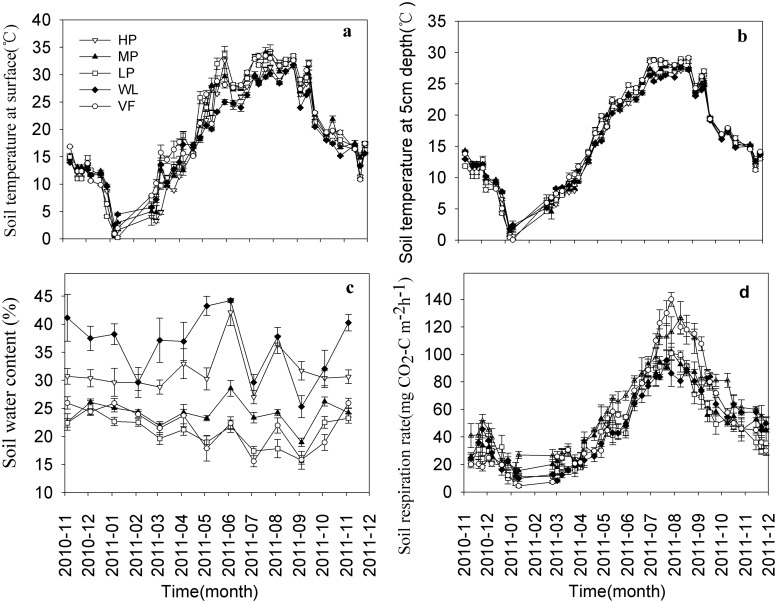
Seasonal change of soil temperature measured (a) at the surface and (b) at 5 cm depth, (c) soil water content in the 0–15 cm soil layer, (d) soil respiration rate at the five experimental sites.HP = tea garden with high production, MP = tea garden with medium production, LP = tea garden with low production, WL = woodland, VF = vegetable field. Vertical bars indicate standard error.